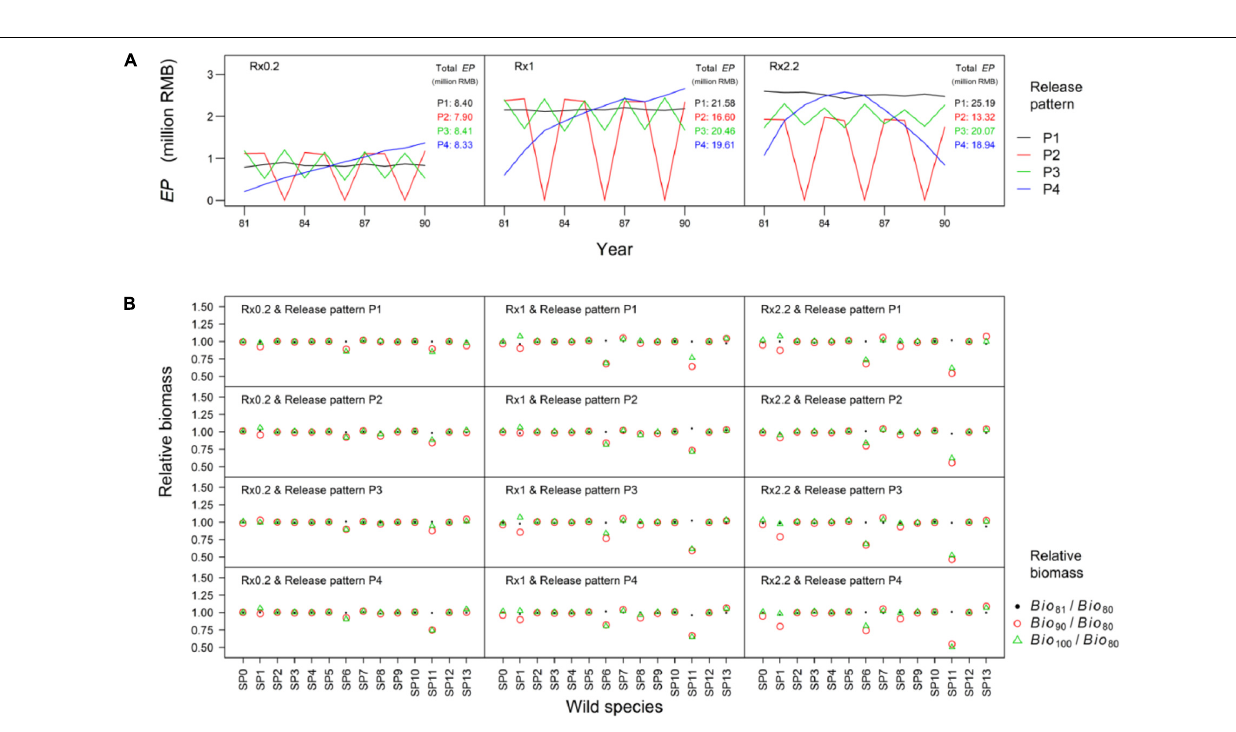
Frontiers in Marine Science |